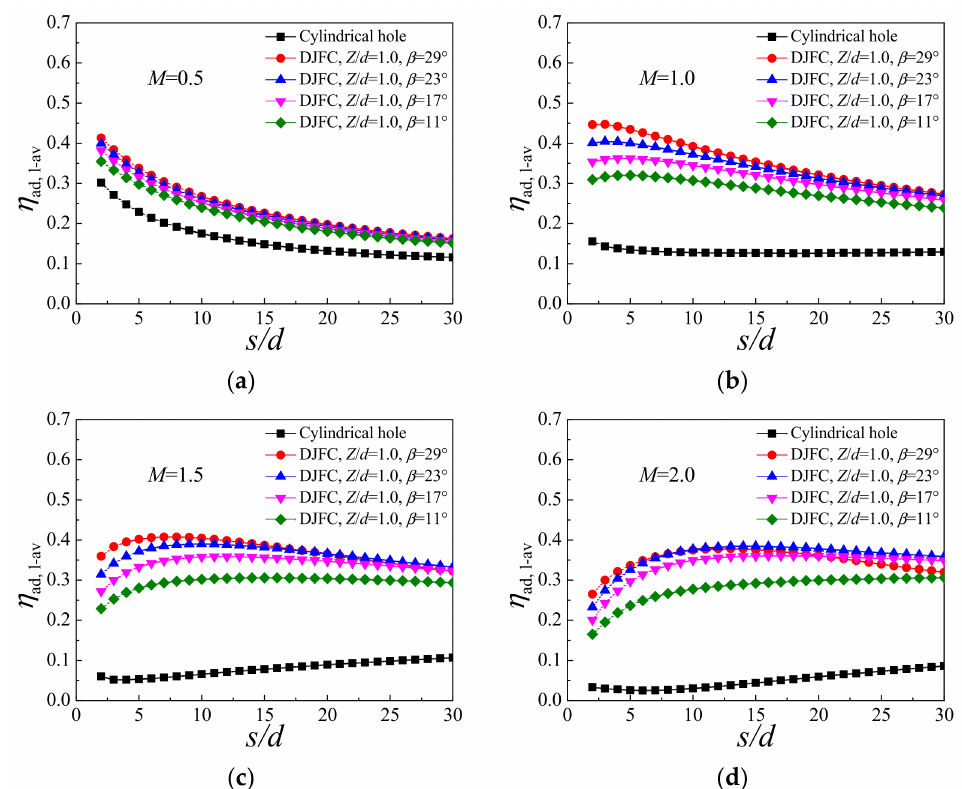
Figure 16. Effect of the spanwise injection angle on laterally averaged film cooling effectiveness on the pressure surface. ( a ) M = 0.5, ( b ) M = 1.0, ( c ) M = 1.5, ( d ) M =